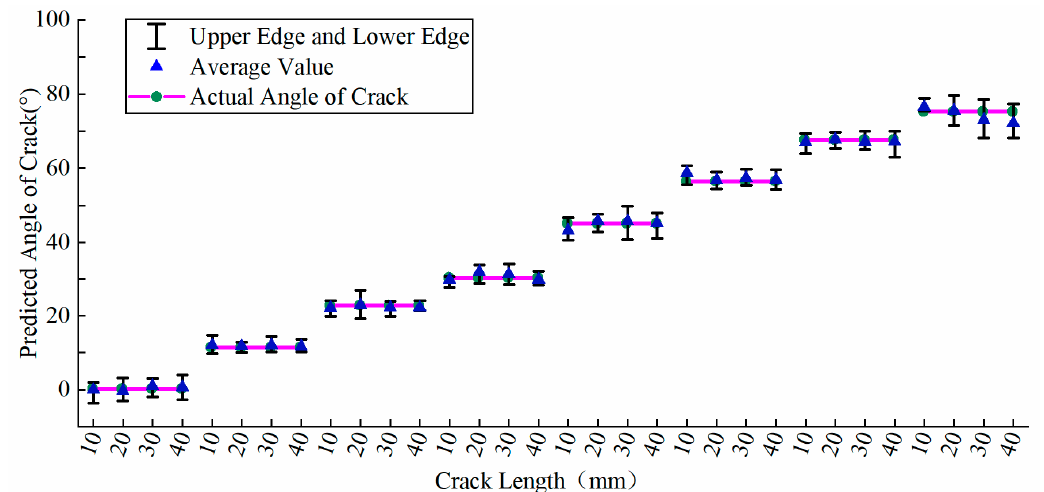
Figure 12. Angle prediction of cracks at different lengths (Multi-BPNN).